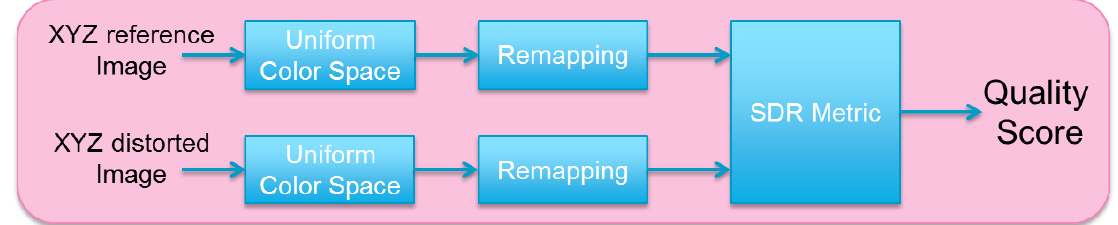
Figure 1. Diagram of the proposed method to adapt SDR metrics to HDR/WCG